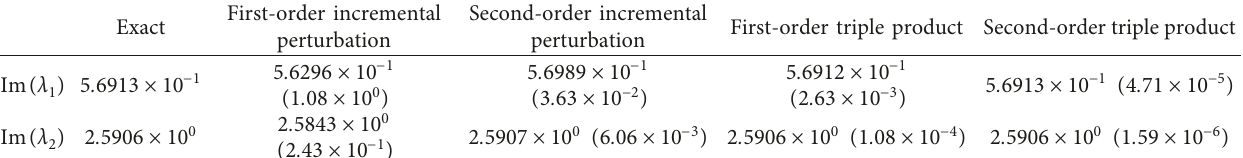
Table 6: The imaginary parts of the exact and approximate natural frequencies for the perturbed two-degree-of-freedom gyroscopic system at N � 10 for σ � 1 .